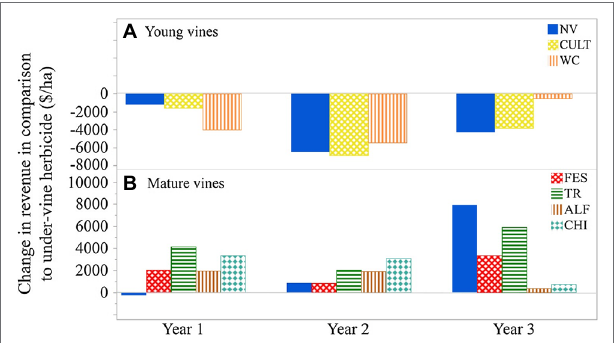
FIGURE 5 | The impact of UVV on change in revenue in comparison with under-vine herbicide. (A) Young Cabernet Franc vines in New York State, data from Karl et al. (2016a). (B) Mature Cabernet Franc vines in New York State, data calculated from Chou and Vanden Heuvel (2019). NV, natural vegetation (weeds); CULT, cultivation; WC, white clover; FES, fescue; TR, tillage radish; AFL, alfalfa; and CHI,